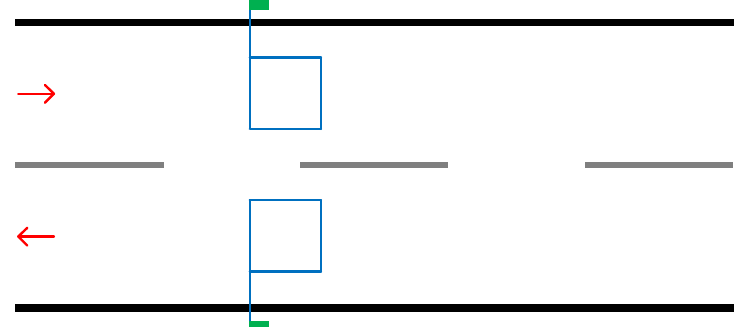
Figure 2. Illustration demonstrating implementation of two induction loops. The blue line represents the wire embedded into the road and the green box representing the power supply and detecting device.